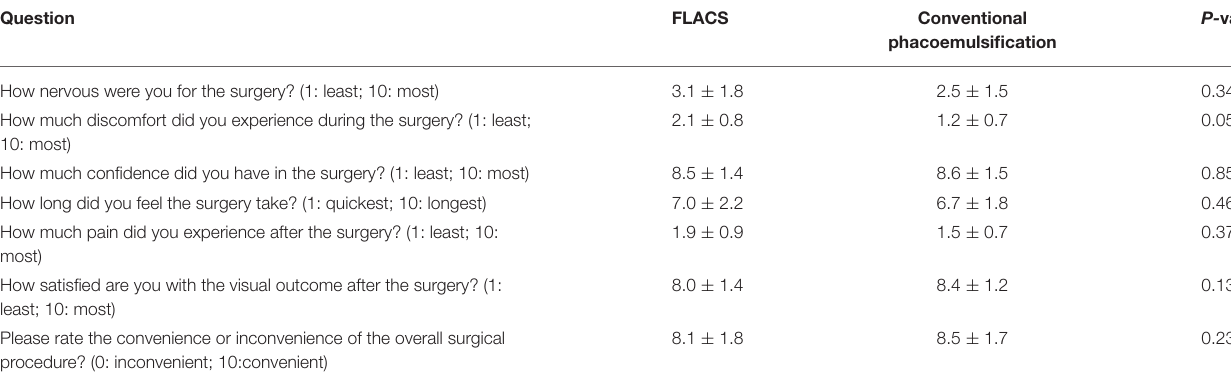
TABLE 2 | Scores of the patients’ subjective pre-, peri-, and post-surgical experiences in the two groups.